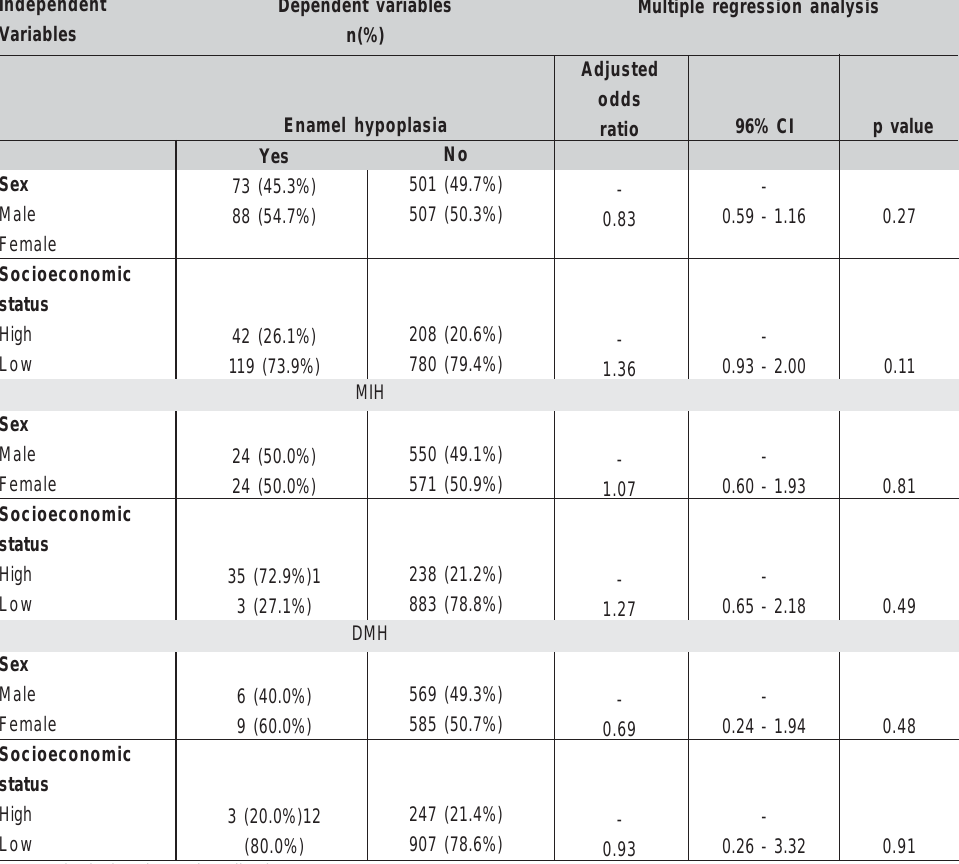
Table 2. Logistic regression analysis for the association between sex, socioeconomic